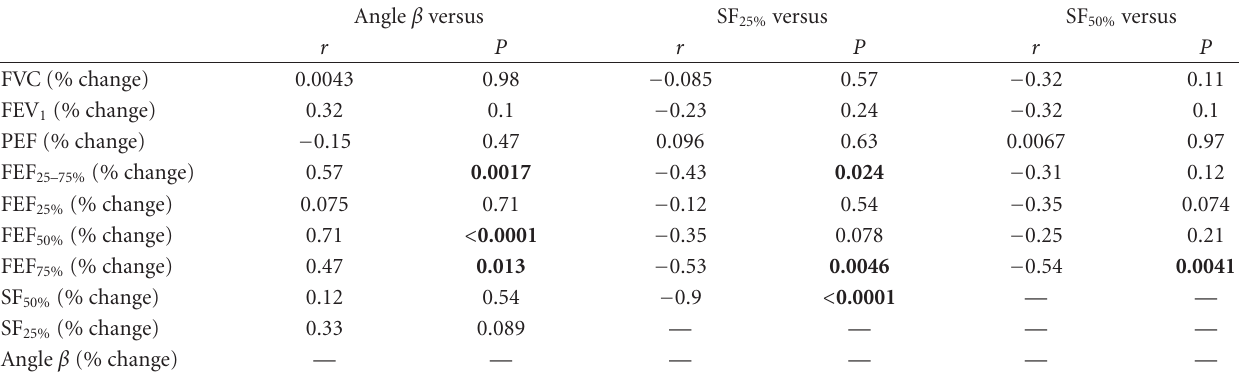
Table 2: Correlation between % changes of angle β , SF 25% , and SF 50% and % changes of spirometric parameters after SABA